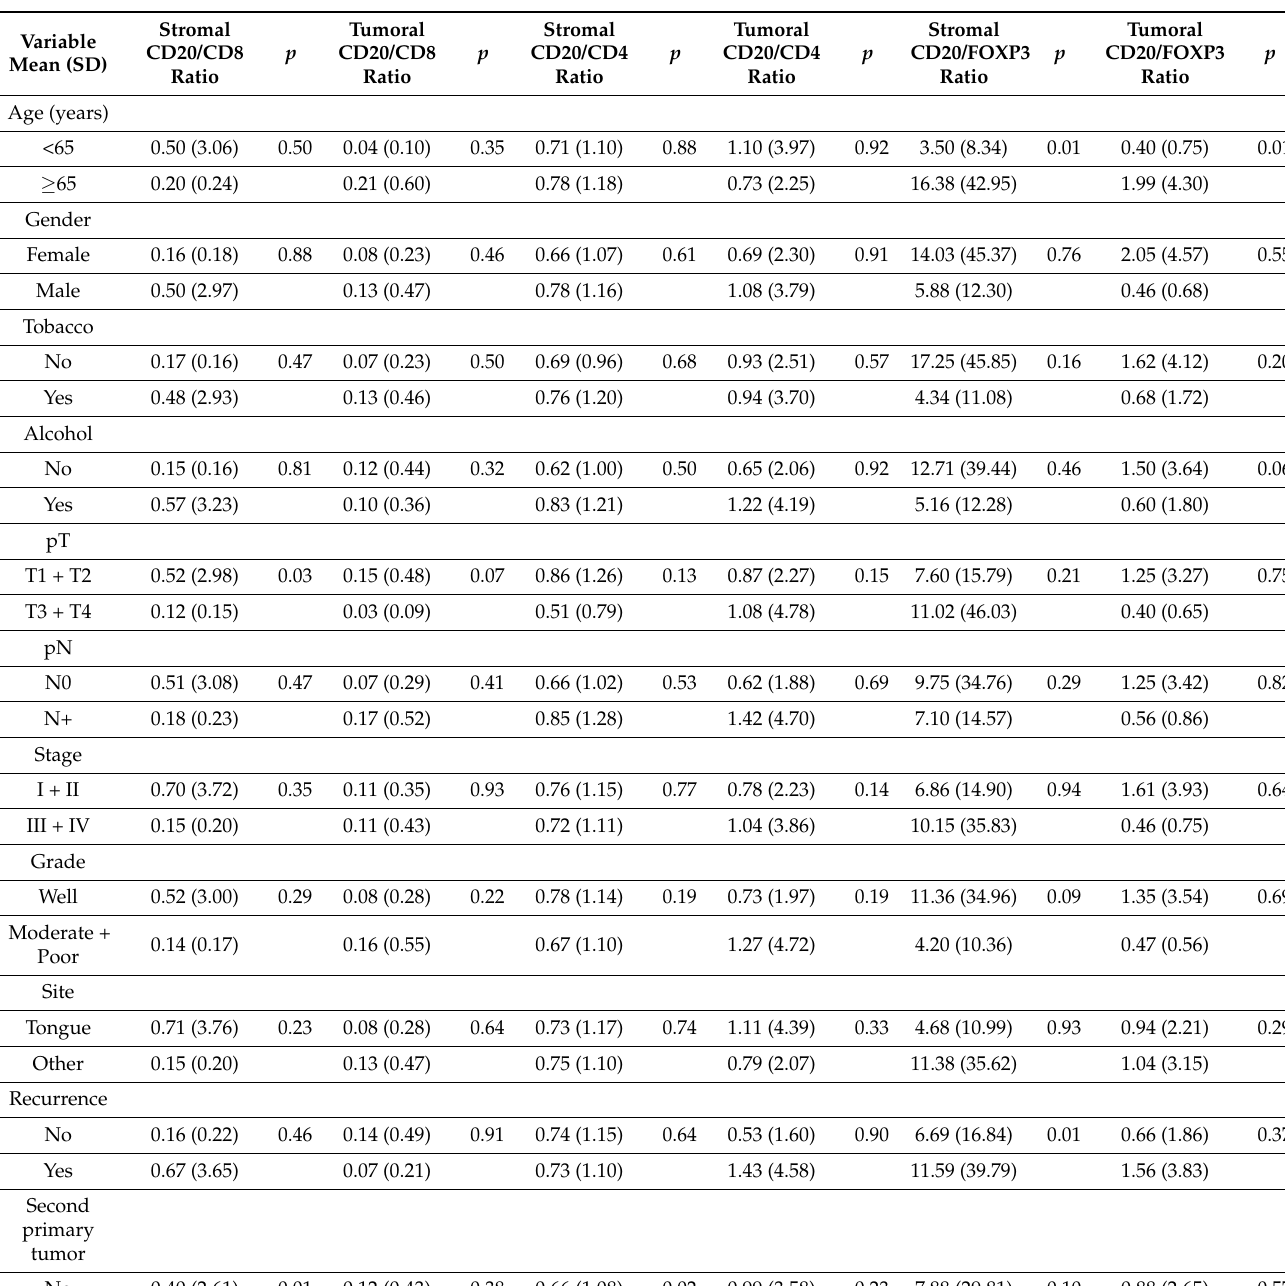
Table 3. Associations between stromal and tumoral CD20/CD8, CD20/CD4, and CD20/FOXP3 ratios and clinicopathologi- cal parameters in the cohort of 125 OSCC